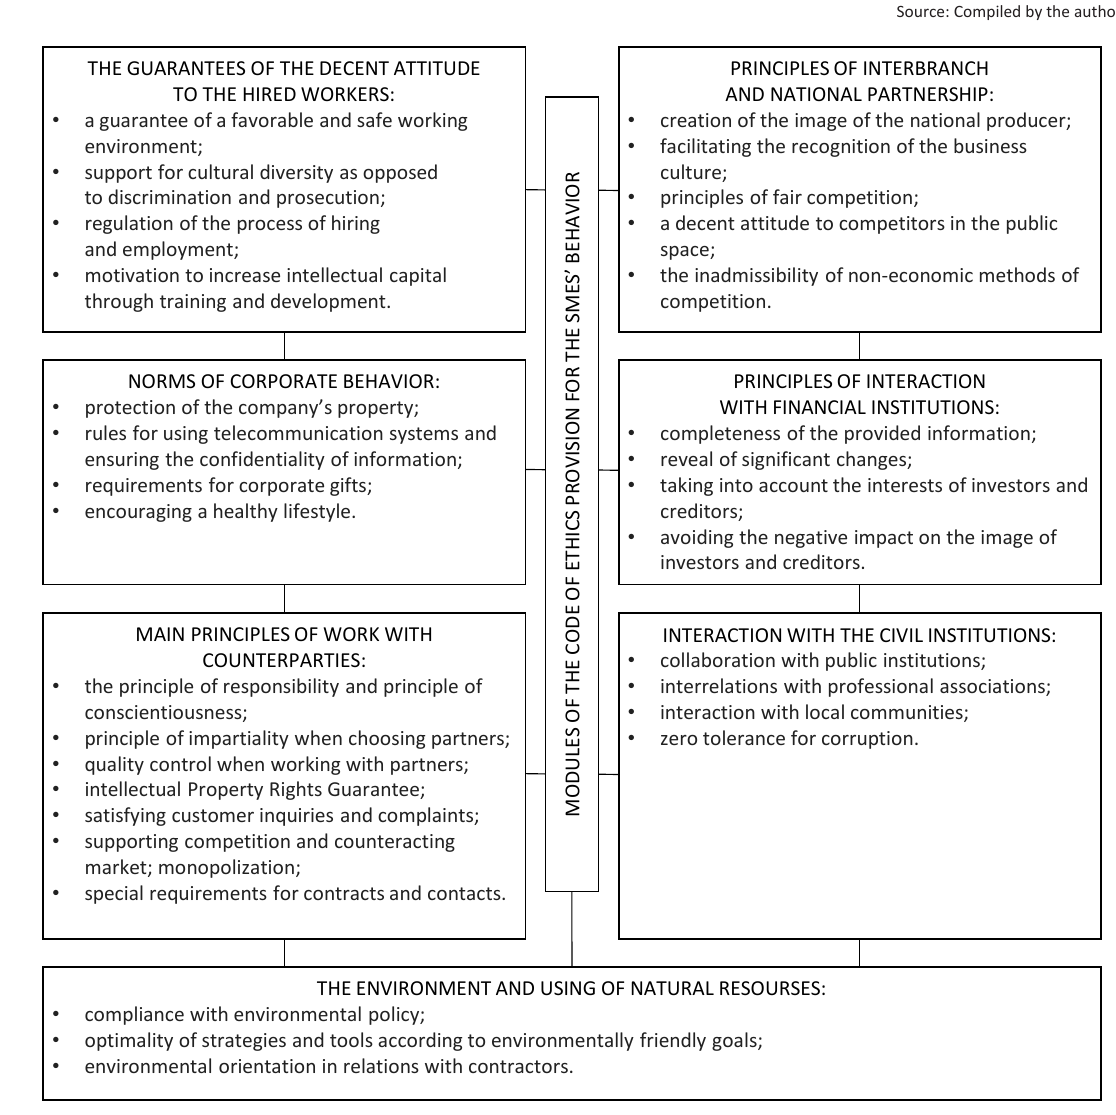
Figure 2. The main modules of the Code of Ethics provision for the SMEs’